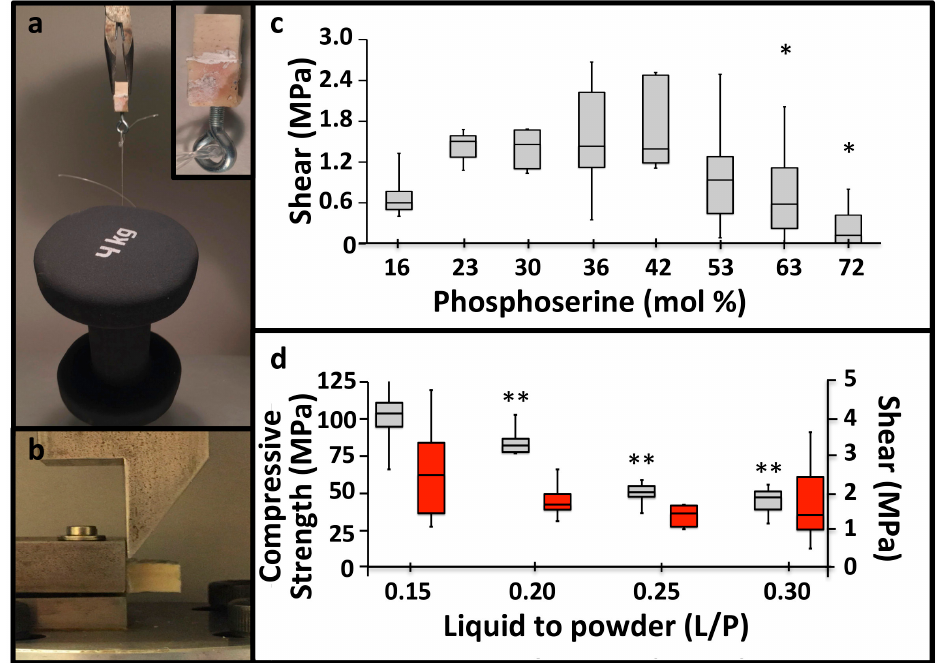
Figure 2. PM-CPC bonds to calcified tissues. ( a ) The adhesive strength of PM-CPC to calcified tissues is visually represented by a 1 cm 2 cortical bone surface, bonded with PM-CPC, supporting 4 kg (0.4 MPa) after curing/setting for 20 min (inset is an expanded image of the glued bone cube). ( b ) The mechanical test rig used for shear testing. ( c ) The shear strength of cortical bone cubes glued together with varied compositions of PM-CPC for 24 h, in liquid. ( d ) The shear and compressive strength of 30% PM-CPC with varied L/P ratios (Figure 2d, 0.15 to 0.3 L/P) (compression—grey bars; shear—red bars; differences in shear strength, between liquid-to-powder ratios compared to 0.15 L/P, are indicated with * ( p < 0.05), and ** ( p < 0.01), ANOVA with Games-Howell post-hoc). Box plots represent the minimum, maximum and median value, with whiskers denoting the first and third quartiles (25%, 75%). In Figure 2c, statistical analysis was used to compare each group to the 30% PM-CPC using ANOVA with Games-Howell post hoc analysis, with * indicating p -values < 0.05. In Figure 2d, the compression and shear samples were analyzed, separately, with Games-Howell, with * indicating p -values below 0.05, and ** indicating a p -value below 0.01.